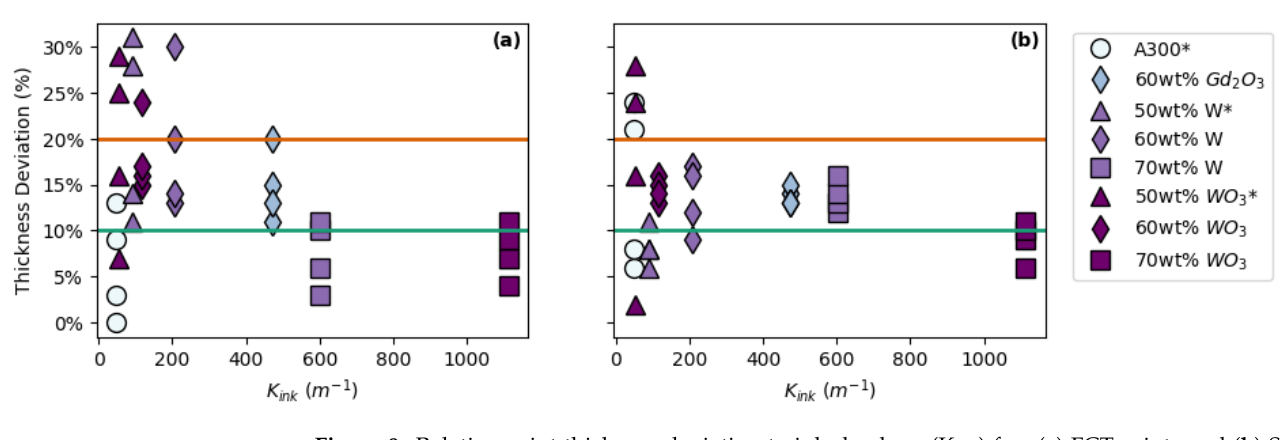
prints. * Data in plot ( a ) from Brounstein et al. [19].